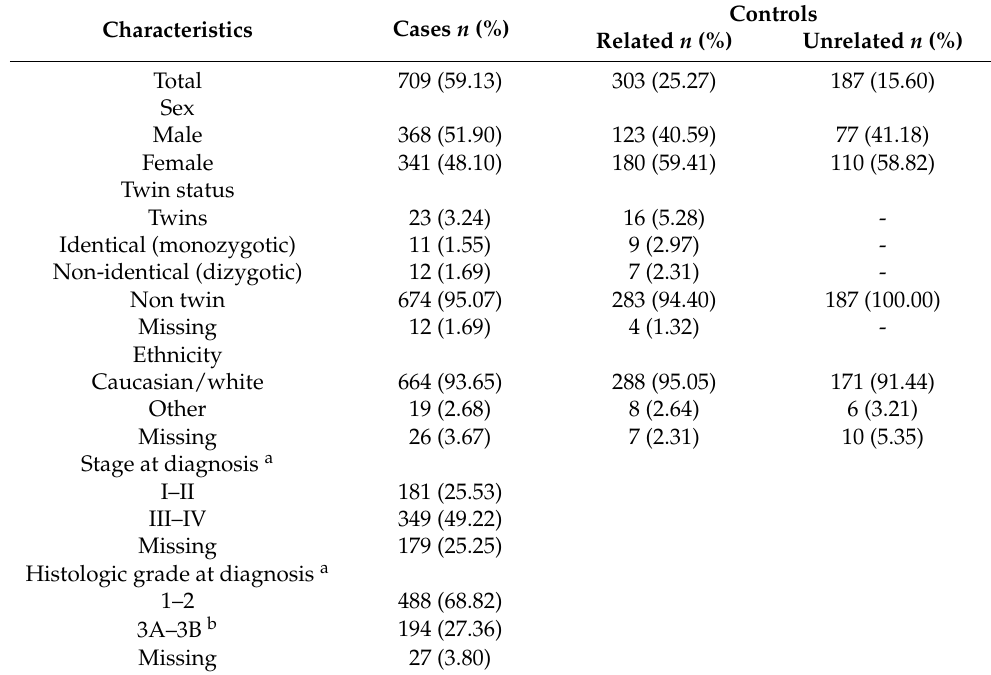
Table 1. Characteristics of follicular lymphoma cases and